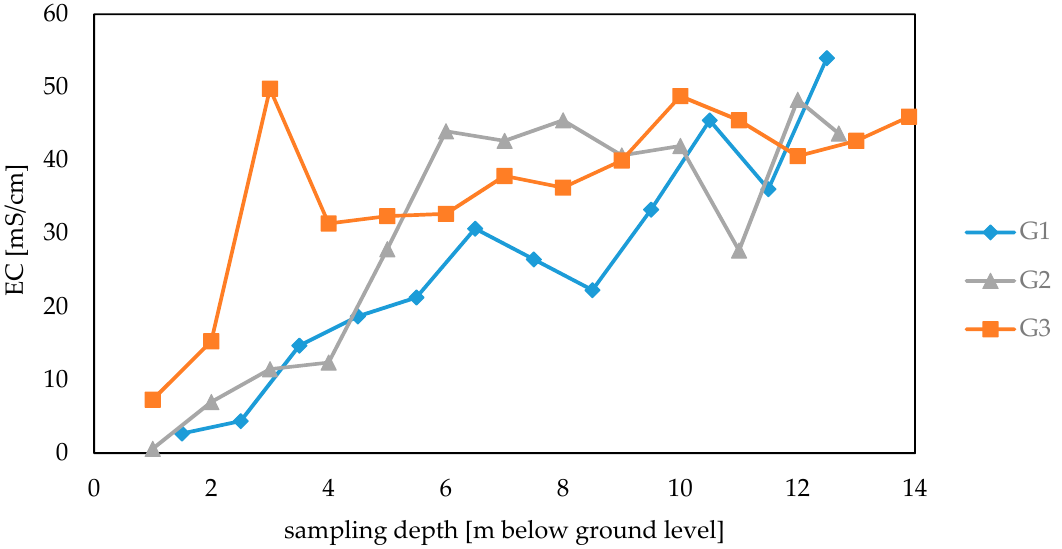
Figure 4. Electrolytic conductivity of water extracts of solid waste collected at the pond 8. Source: own study .